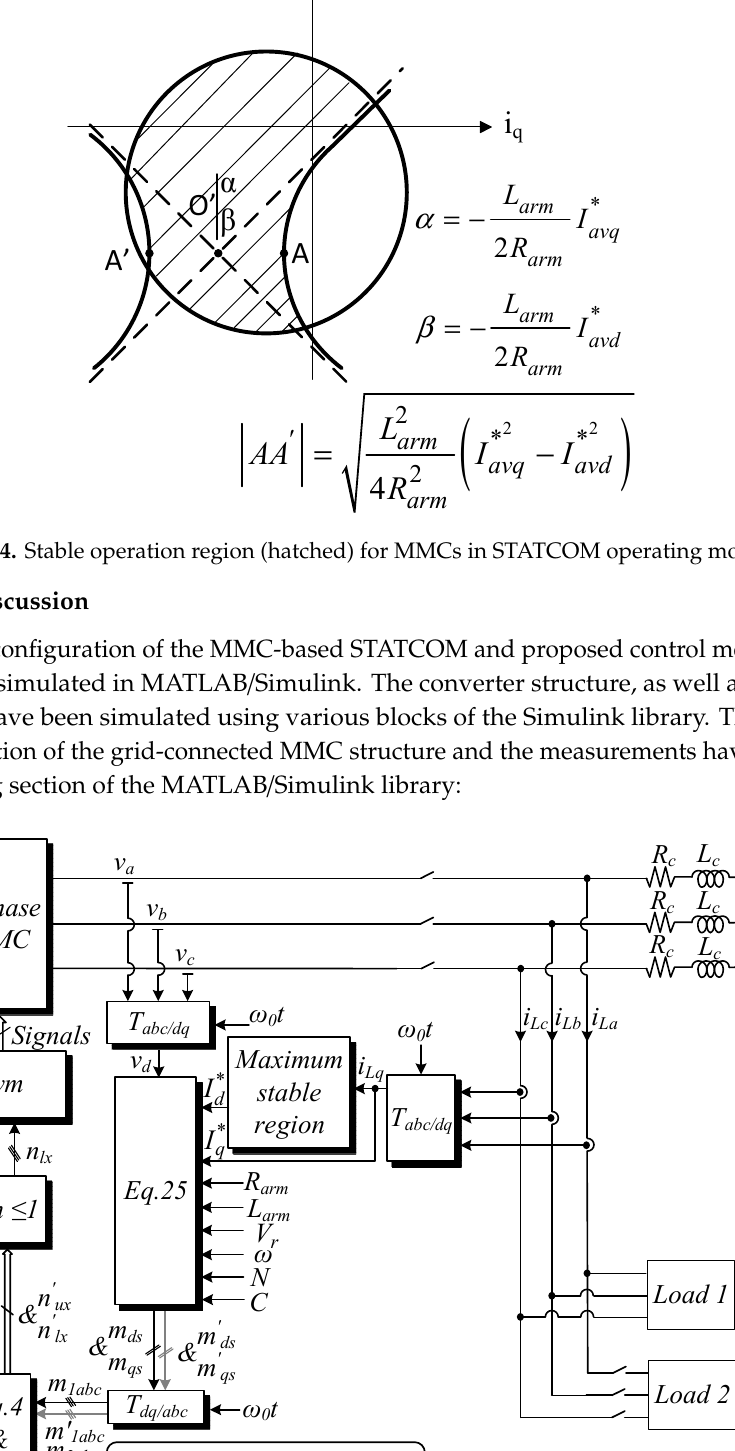
Figure 5. General configuration of the proposed MMC-based STATCOM controller.